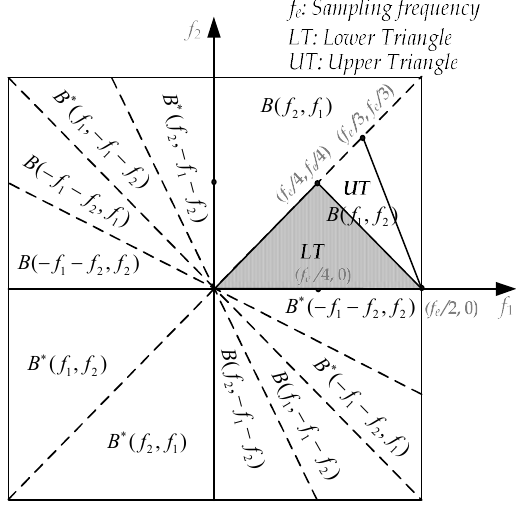
Figure 4. Bispectrum symmetry regions.